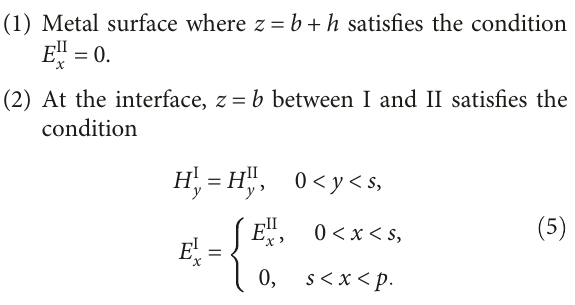
Figure 4: PPW fi lled with rectangular grating is equivalent